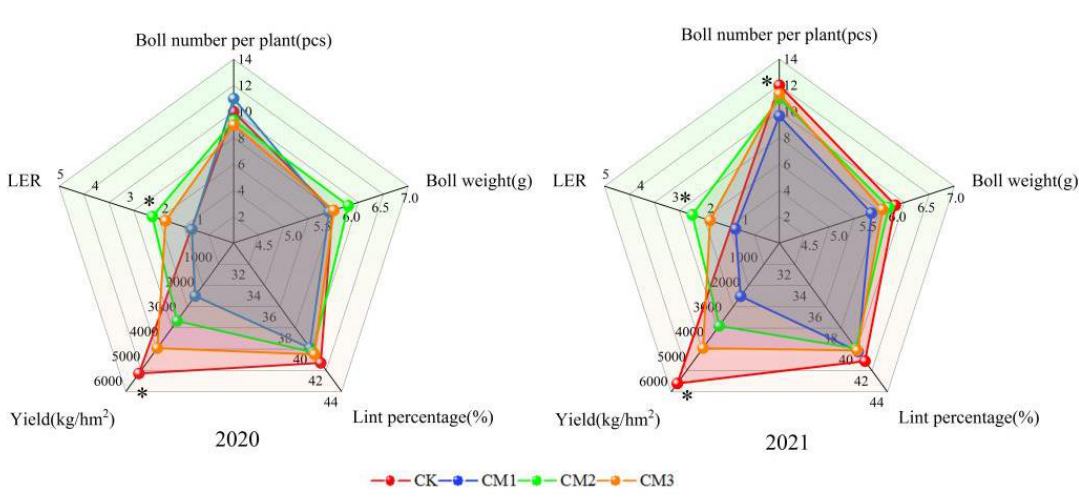
Figure 11. Effects of different configuration treatments on cotton yield and yield components . * represents significant difference at the p > 0.05 level.